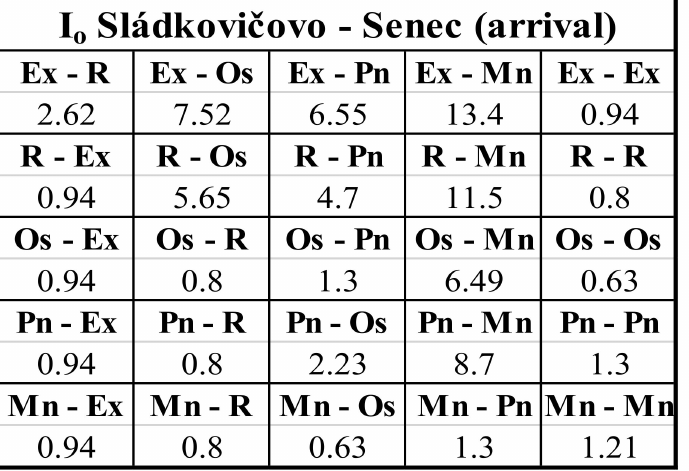
Figure 9. Resulting headway times (in minutes) for Senec railway station—direction from Sl á dkoviˇcovo station, ETCS